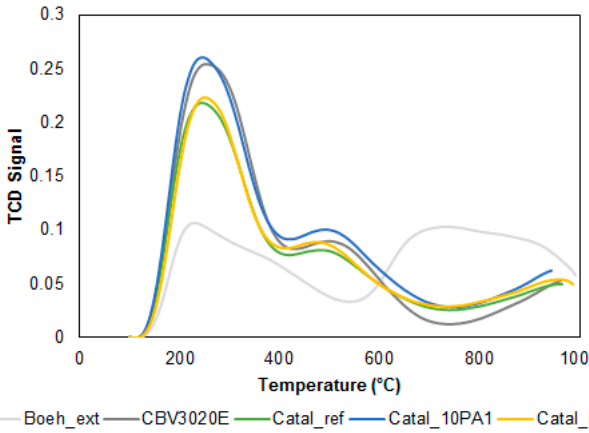
Figure 3. Temperature programmed desorption of NH 3 (NH 3 -TPD) profiles of as-synthesized catalysts.